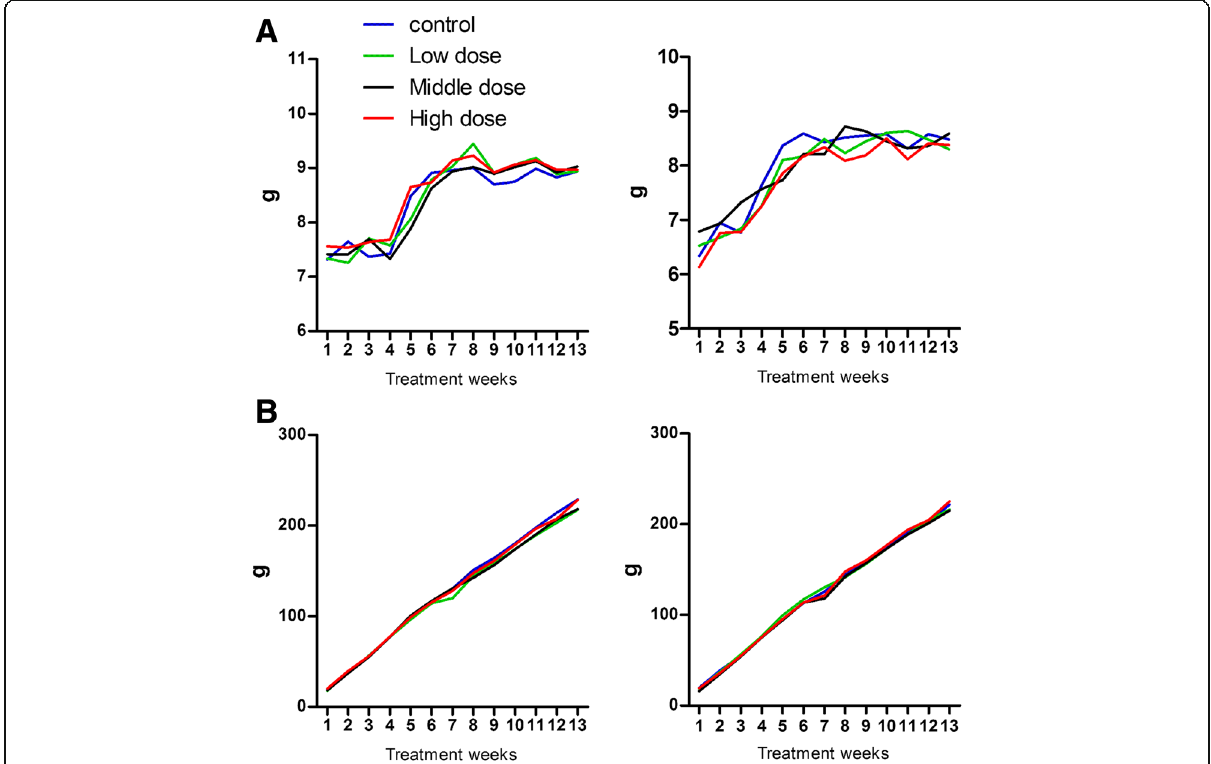
Fig. 1 JDHF treatment does not alter food consumption or body weight. Wistar rats were treated with or without JDHF for 13 weeks. Food consumption ( a ) and body weight ( b ) were measured. Significance is indicated as P > 0.05